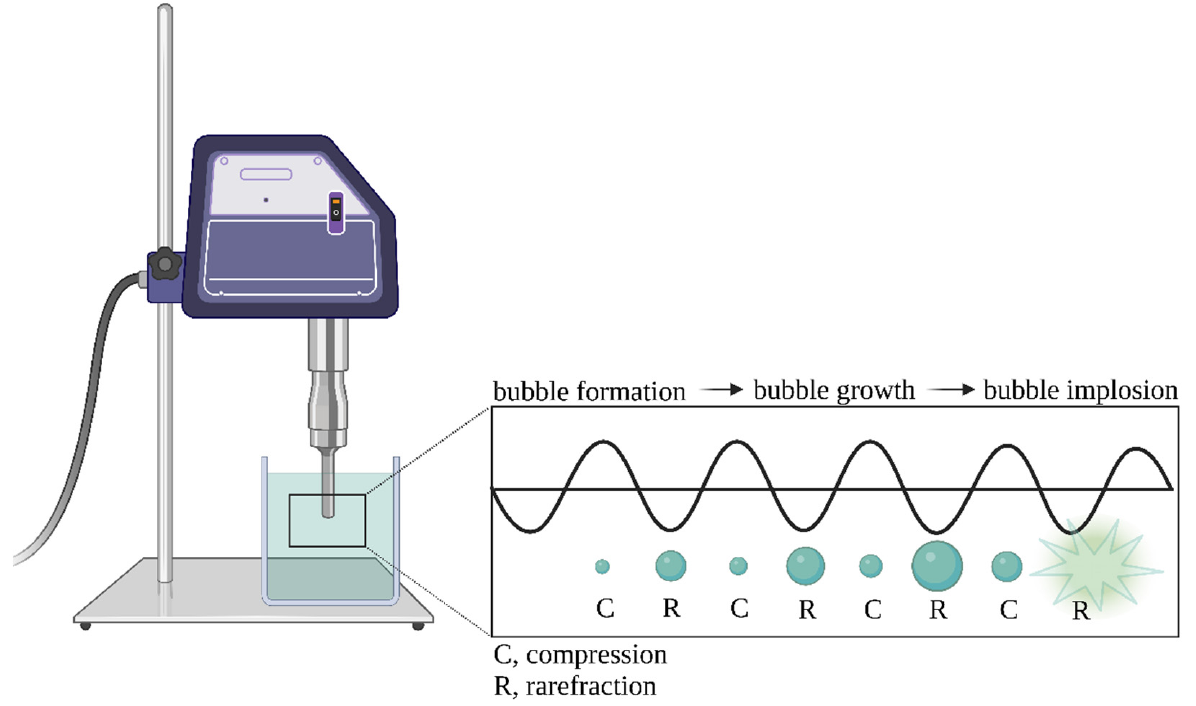
Figure 5. Cavitation phenomenon caused by ultrasonication.